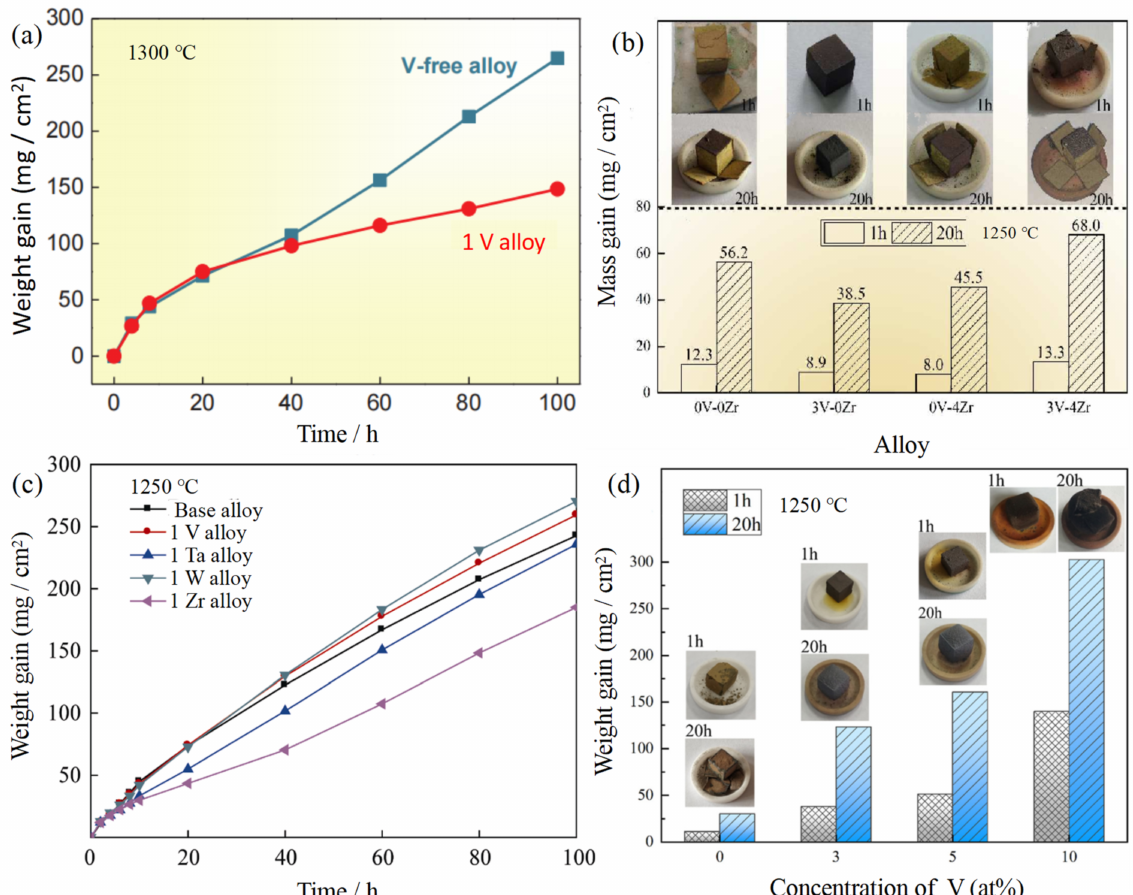
Figure 13. Weight gain curve of Nb-Si-based alloys after adding V. ( a ) Nb-15Si-24Ti-4Cr-2Al-2Hf-xV (x = 0, 1 at.%). ( b ) Nb- 22Ti-15Si-5Cr-3Al-2Hf-xV-yZr ((x, y) = (0, 0), (3, 0), (0, 4), (3, 4) at.%). ( c ) Nb-15Si-24Ti-4Cr-2Al-2Hf alloys with separate V, Ta, W and Zr additions. ( d ) Nb-22Ti-15Si-5Cr-5Mo-4Zr-3Al-2Hf-xV (x = 0, 3, 5, 10 at.%). Copyright 2017 Elsevier, 2021 Elsevier, 2017 Springer Nature and 2020